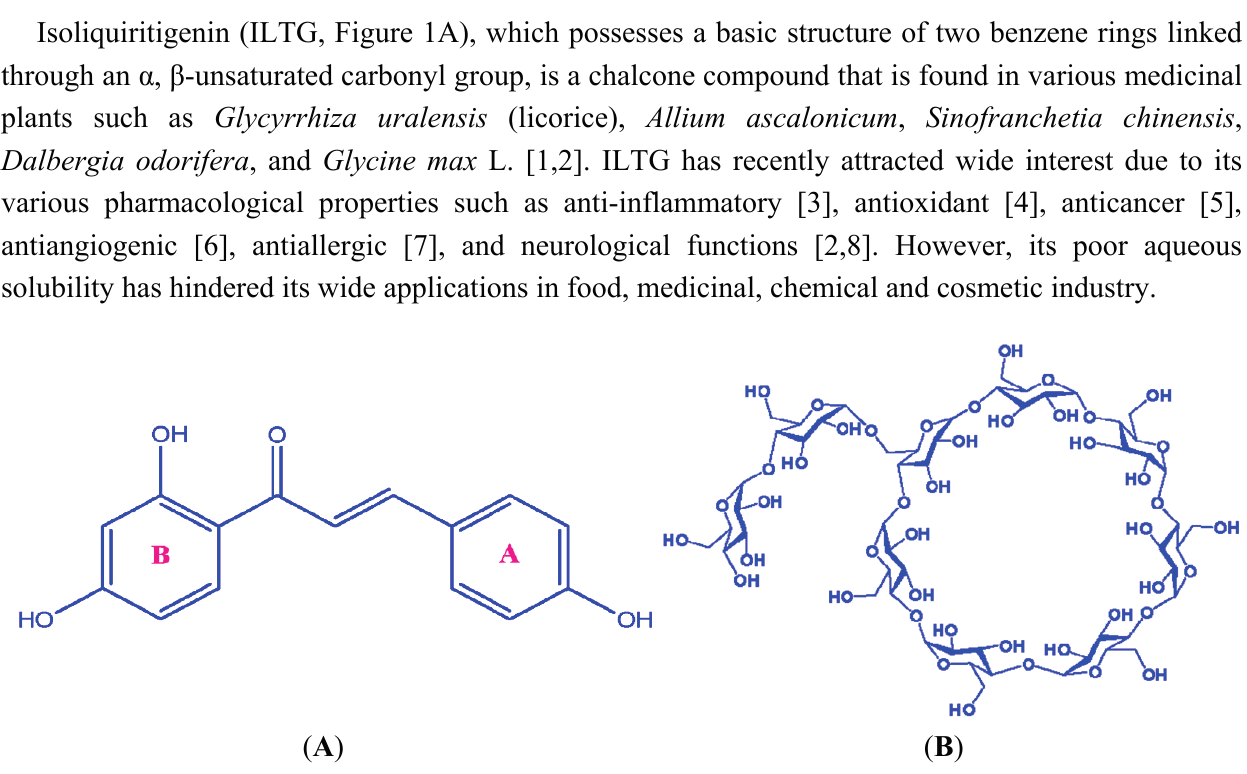
Figure 1. Chemical structures of ( A ) Isoliquiritigenin (ILTG) and ( B ) G 2 - β